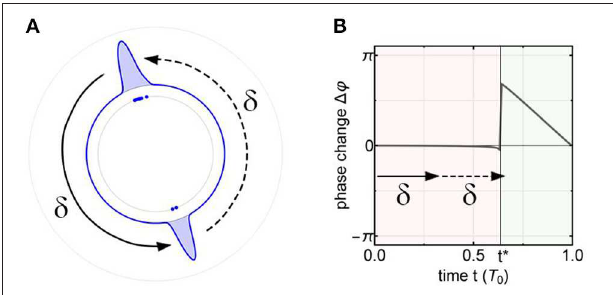
FIGURE 3 | Cluster state mechanism. (A) The smoothed polar histogram shows two antiphasic subpopulations in a globally coupled network. They perturb each other a time δ after they have been perturbed themselves, respectively. Parameters: N = 100, K = 1.4 × 10 − 4 , τ = 8.67. Other parameters as in Figure 2 . (B) The 2-cluster state emerges if the perturbation from the other cluster arrives in the vulnerable window (green) given by the jump point t* in the